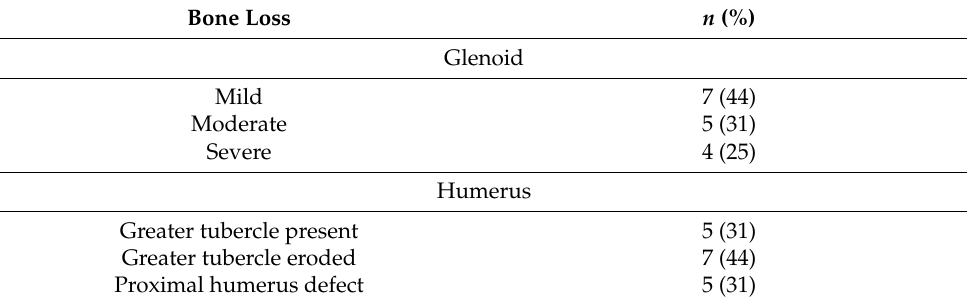
Table 2. Bone loss at second-stage